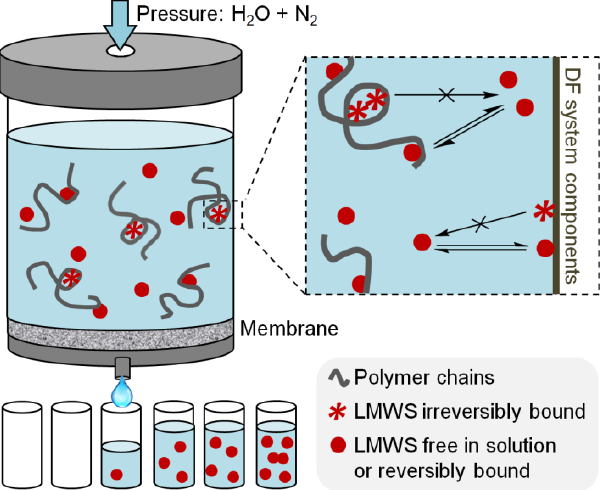
Figure 1. Scheme of a typical diafiltration system ( left ) and interaction model between low molecular-weight species, water-soluble polymers, and the diafiltration system components ( right ).